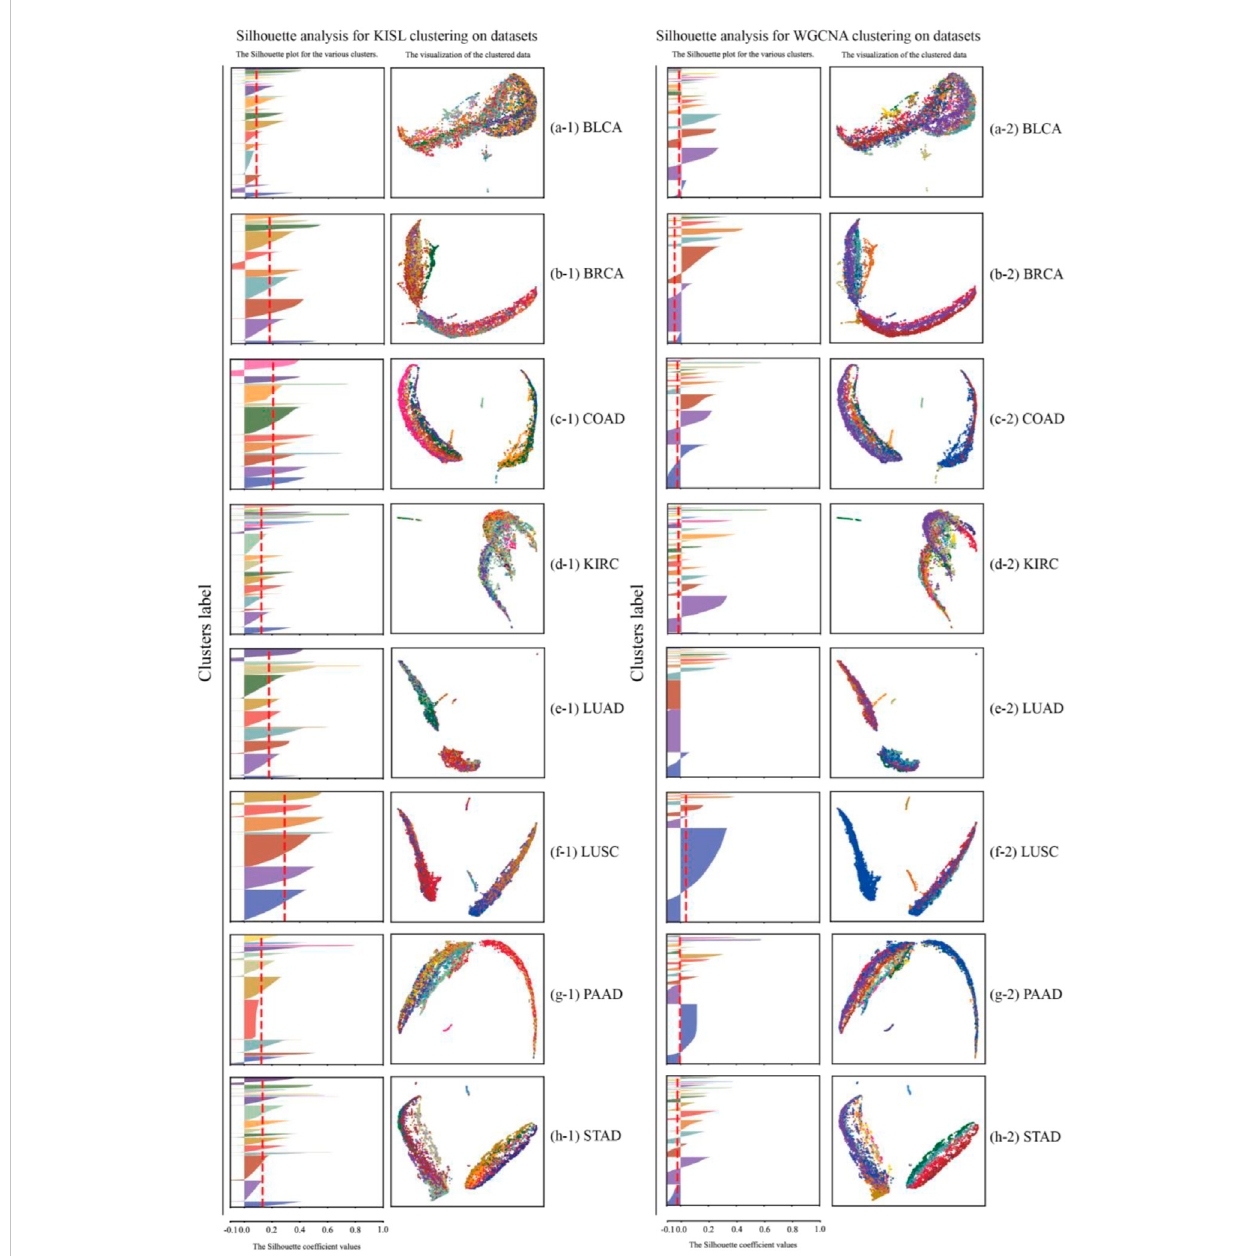
FIGURE 6 Silhouette coef fi cient analysis for the WGCNA and KISL algorithms. The left panel shows the results of silhouette coef fi cient analysis of the clusters obtainedbytheKISL.TherightpanelshowstheresultsobtainedbythebasemethodWGCNAonthecorrespondingdataset.Theevaluationvalue(thered dashed line) obtained by the KISL algorithm was the highest in all the datasets. In each panel, the left part represents the silhouette coef fi cient value of each sample, the y -axis represents the sample sequence, and the x -axis represents the silhouette coef fi cient size. UMAP visualization results are displayed on the right side of each